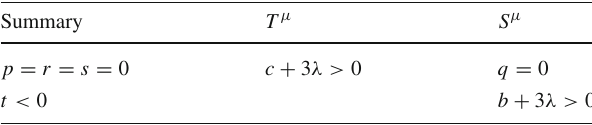
Table 2 Compatibility of the stability conditions studied in this paper. In the first column we show necessary conditions for a theory propagat- ing vector or pseudo-vector torsion to be stable. Those conditions have to be implemented (at least) by the inequality contained in the second column when the vector mode propagates and by the conditions of the last column when the pseudo-vector also